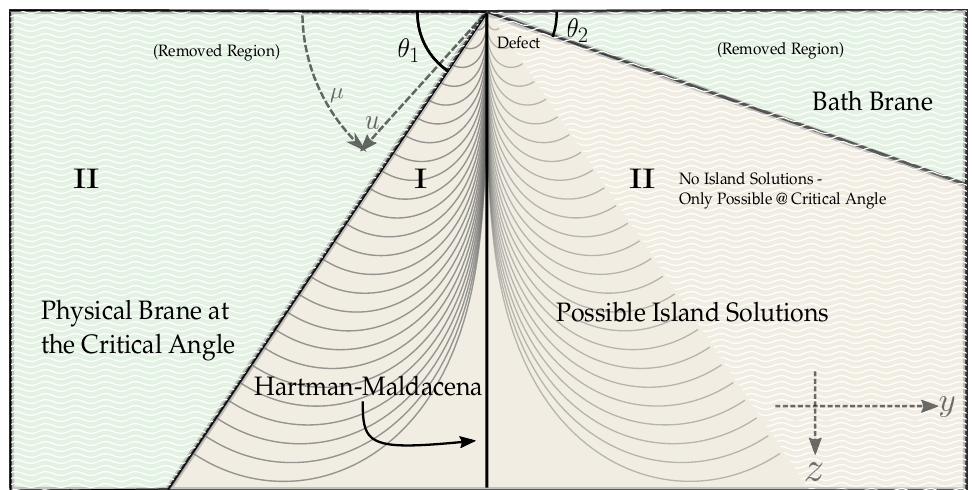
Figure 9: Possible island surfaces in empty AdS , which exist only for a brane d + 1 < θ placed at the critical angle. To summarize, we have two distinct cases. If θ P 1 < θ and θ , the left / right entanglement entropy for the AdS black string follows P 2 a Page curve, with the Page time determined by the stronger brane. Otherwise, we have no Page curve, and the left / right entanglement entropy is simply constant. These are relevant for the black string geometry, since island surfaces near the bound- ary are increasingly well approximated by empty AdS. The island surfaces completely < µ < π − θ fill the island commonwealth ( θ ), region I, without crossing one an- c c other. They also fail to make it into region II, the independent territory ( µ < θ or c µ > π − θ c